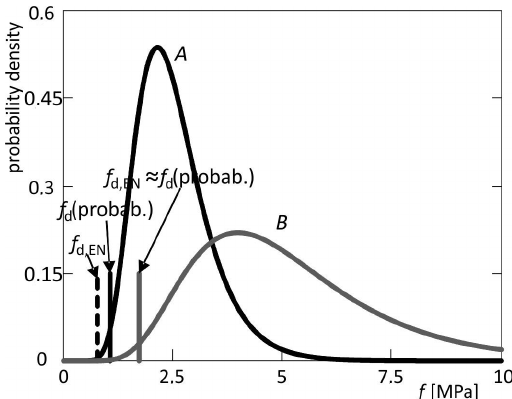
Fig. 11. The probability density function of masonry strength and design values Table 3. Characteristic and design values of masonry strength (in MPa) and partial factors Alternative Variable Deterministic